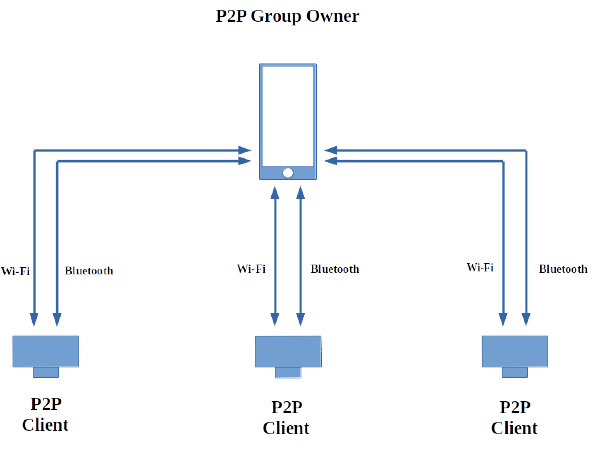
Figure 4. P2P topology 1:n, used by the camera nodes and smartphone.